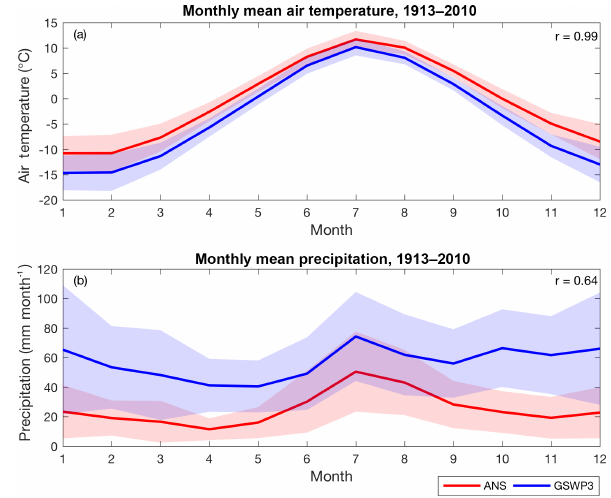
Figure 3. Monthly mean air temperature (a) and precipitation (b) measured at ANS (red) and extracted from GSWP3 (blue). The shaded area is the interannual variability for the corresponding dataset, represented by the standard deviations calculated for each month. The inset r values are the correlation coefficients calculated between the two time